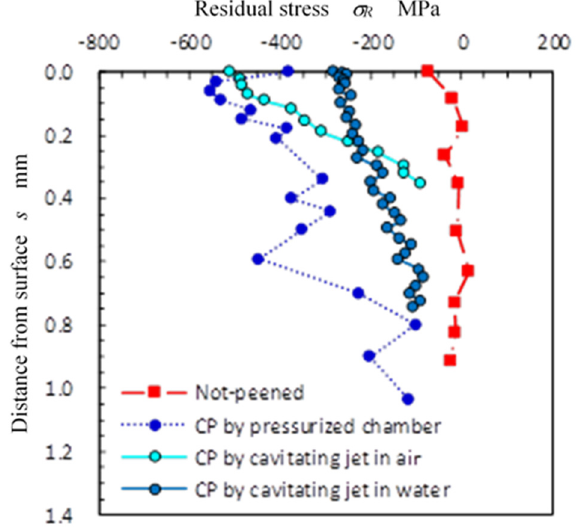
Figure 12. Compressive residual stress introduced by several types of cavitating jets (stainless steel) [3].